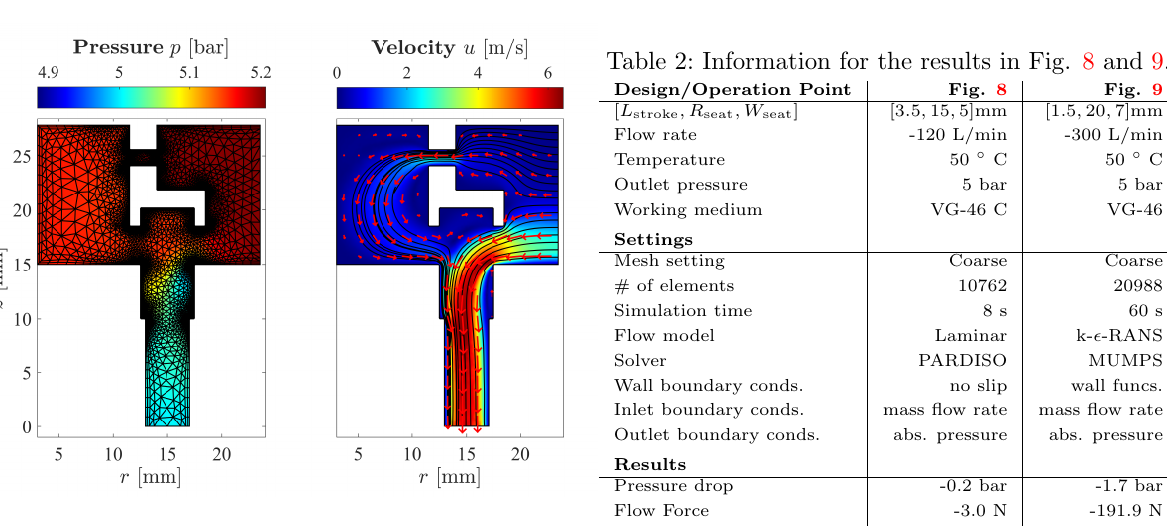
Figure 8: Pressure and velocity distributions for a flow rate of -120 L/min obtained using the Lami- nar model.